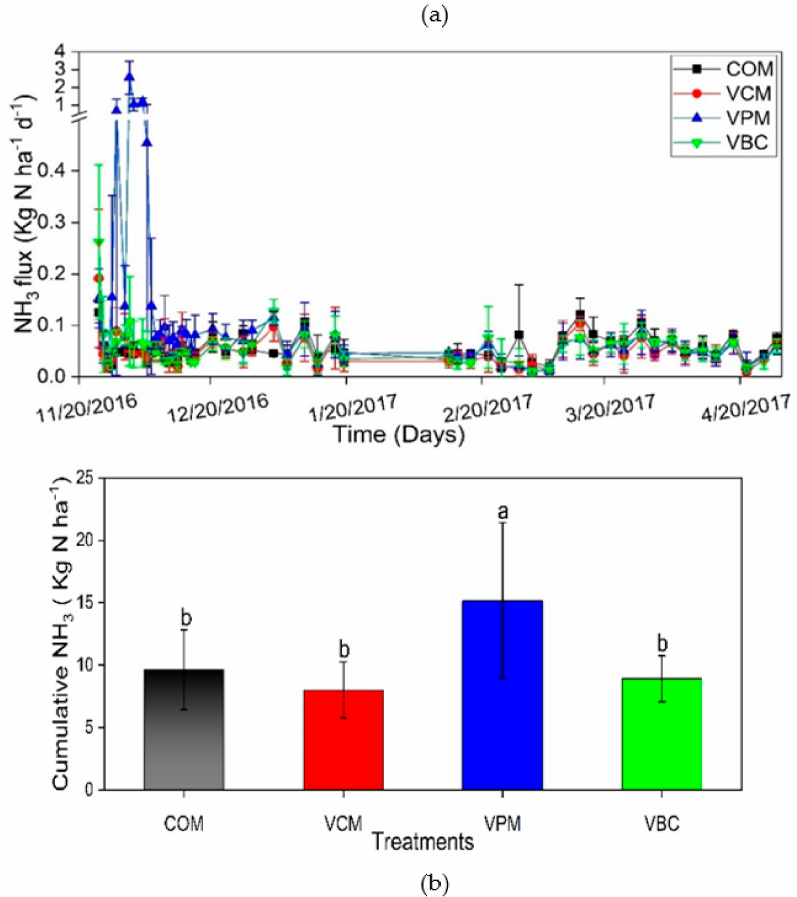
Figure 5. NH 3 volatilization ( a ), cumulative NH 3 ( b ), during experimental duration. Error bars represent standard errors ( n = 3). Different letter indicates significant differences among treatments ( p <